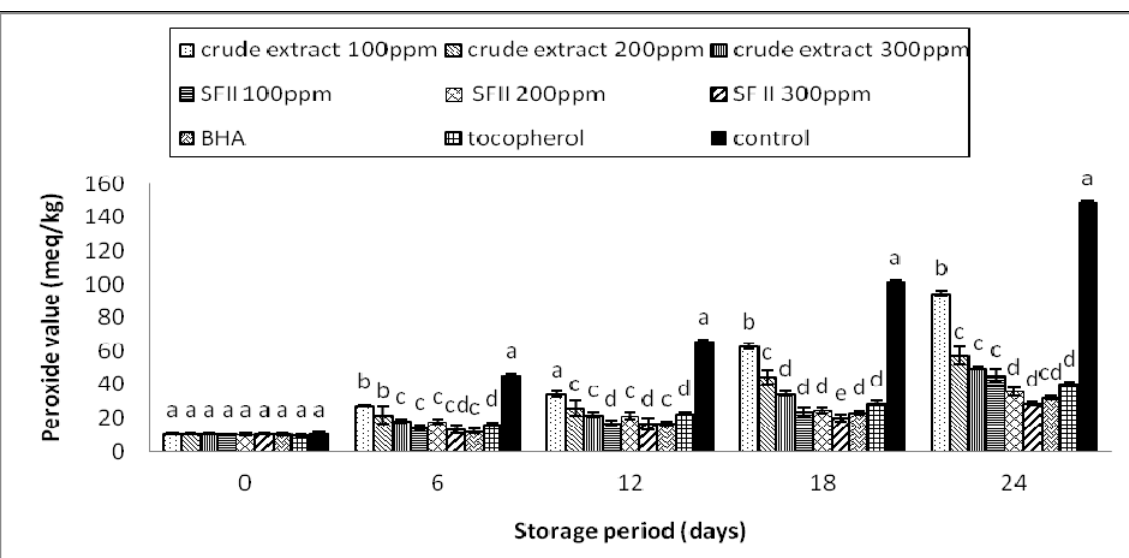
Figure 1. Peroxide value of the supplemented sunflower oil with rambutan extracts, butylatedhydrioxynanisole (BHA) and tocopherol under accelerated storage at 65 °C for 24